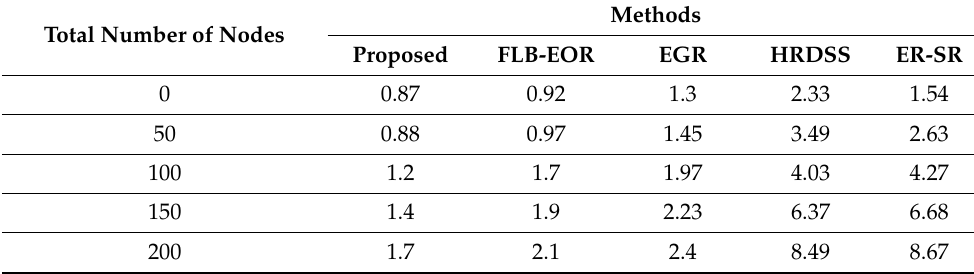
Table 9. End-to-end delay